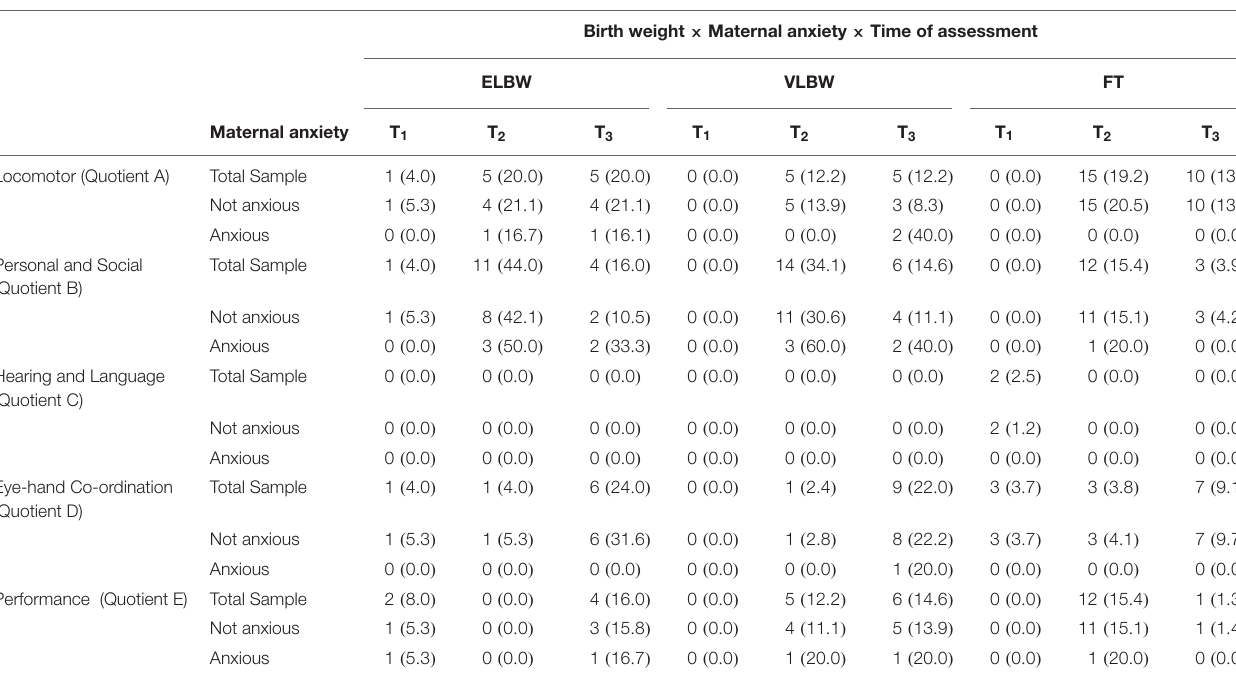
FIGURE 1 | Performance and Healing and Language quotients according to the interaction between birth weight and time of assessment. * p < 05; ** p < 0.005. Continue line denotes within group comparison; dotted line between group comparison. TABLE 3 | Prevalence of delay ( < 1 DS) on the